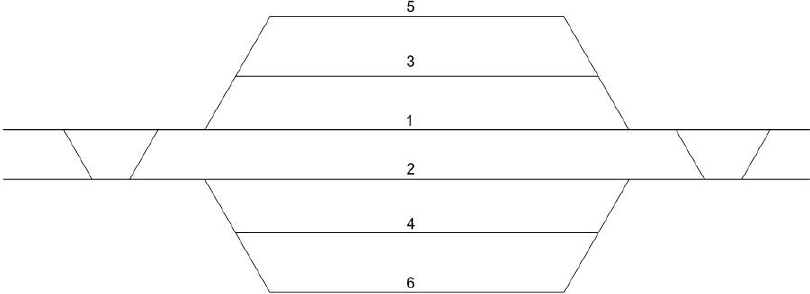
Figure 4. Track layout diagram of another small overtaking station on a double-track line (it has two sidings on each of the sides of the main line and two crossovers at the two throats of the station). For example, the station Cuenca Fernando Zobel (on the Spanish high-speed line Madrid–Valencia) has exactly this track layout [4] (p. 68). Fukushima station (on the Japanese Tohoku Shinkansen line) is very close to this one; the only difference is that it has only one crossover at one of the throats of the station [4] (p. 36). Similarly, Camp de Tarragona station (on the Spanish high-speed line Madrid–Barcelona [4] (p. 62)) has three sidings on each of the sides of the main line; however, it has crossovers only on one throat of the station.